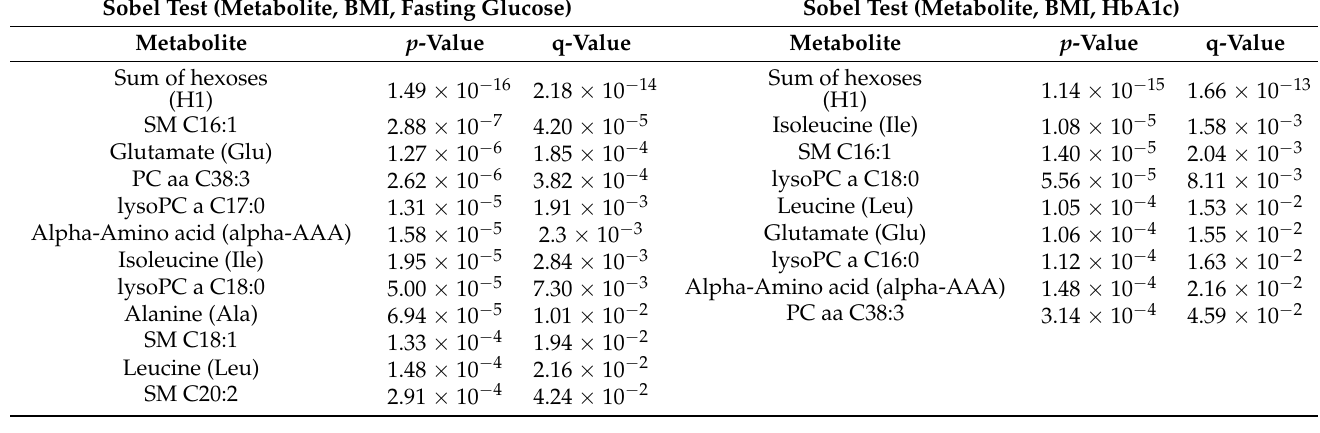
Table 5. Results for mediation analysis with the BMI as independent variable, metabolite as potential mediator, fasting glucose or HbA1c as dependent variable. q-values were reported as p -value adjusted for multiple testing by Bonferroni correction.